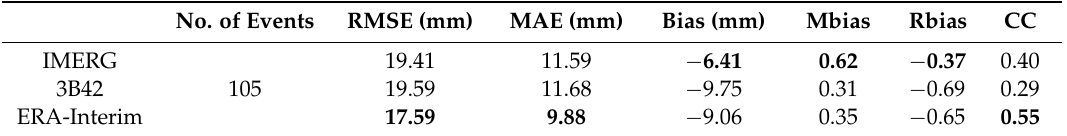
Table 5. Statistical indices of daily precipitation events in Bushehr area (mid-March 2014 to February 2015).